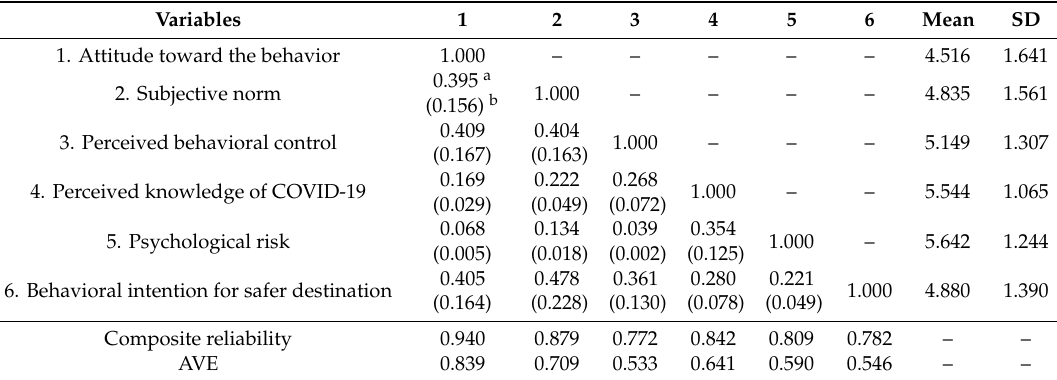
Table 1. Measurement model